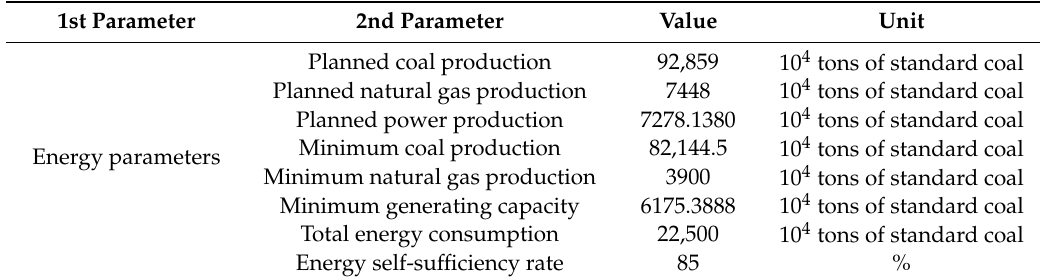
Table 7. Energy parameters of the water–energy–food system in Inner Mongolia.